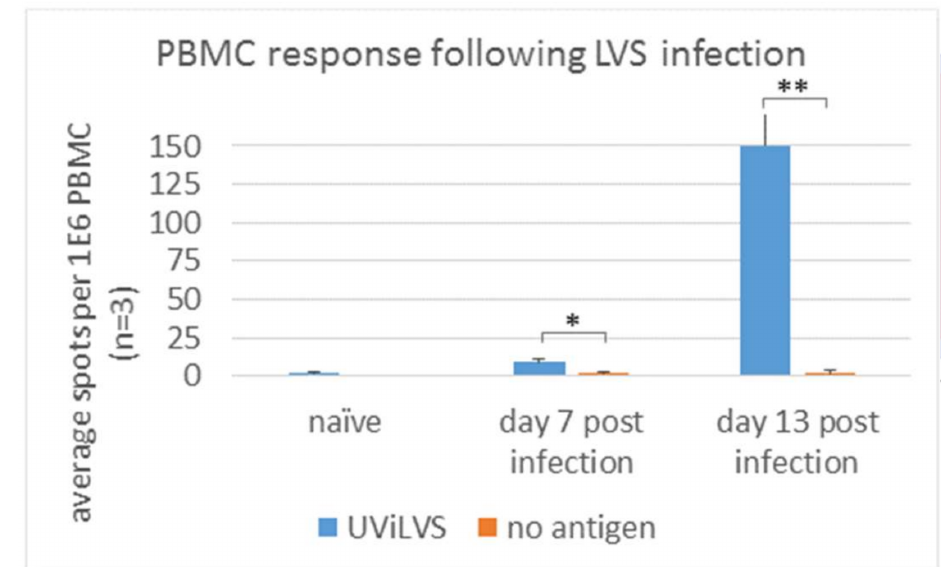
Figure 4. ELISPOT response in the blood following F. tularensis infection. Groups of three mice were infected intranasal with F. tularensis LVS (100 cfu) and bled 7 and 13 days post infection. PBMC from naïve and infected mice were stimulated with UViLVS as describe or left untreated. Data are representative of two independently performed experiments. * p < 0.05, ** p <